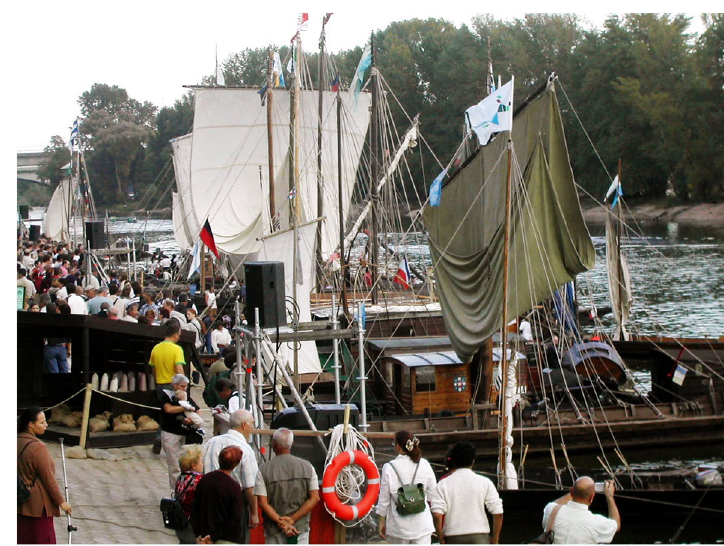
Fig. 11 Loire Festival in September, Orléans, 2007 (Source: Alain